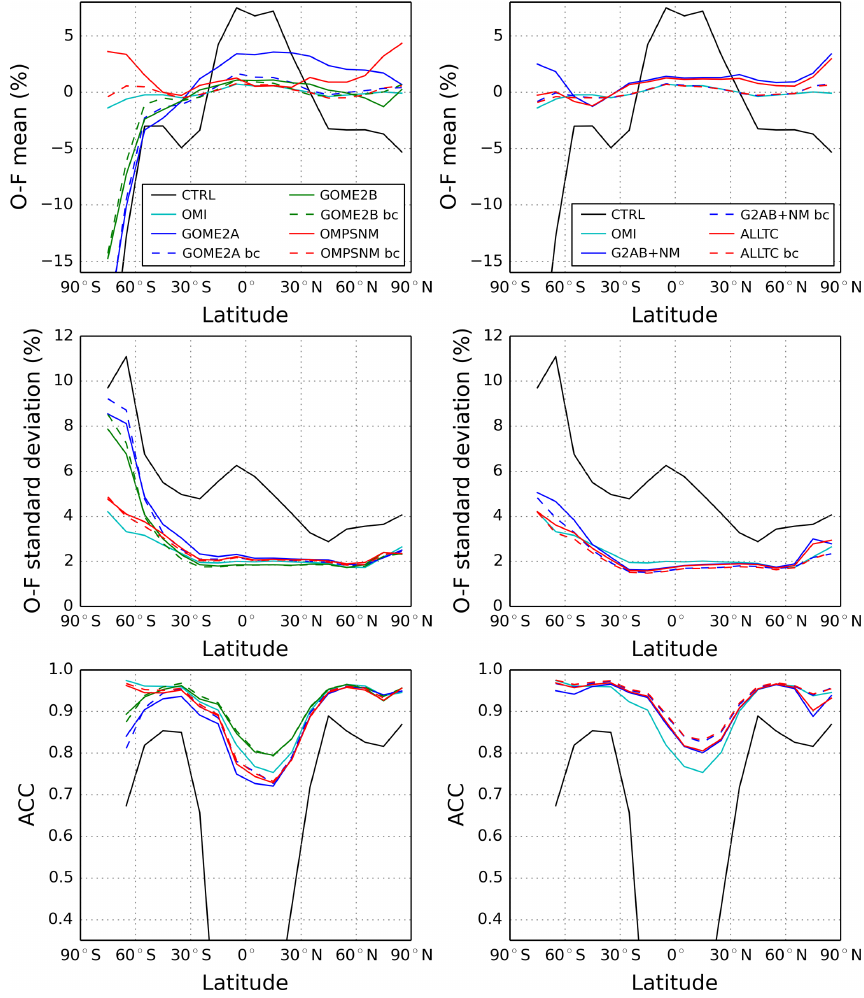
Figure 8. Zonal mean total column ozone statistics of mean differences (%), standard deviations (%), and anomaly correlation coefficients (ACC; unitless) as a function of latitude (degrees) for the comparison between OMI-TOMS measurements and short-term forecasts for July–August 2014. The legends in the top plots indicate the assimilation run (see Table 5 for description) and apply to all plots in the same